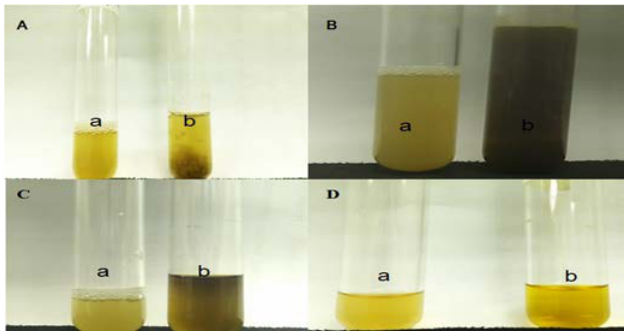
Figure 8. Phytochemical qualitative analyses of S. polyanthum leaf methanolic extract (ME): ( A ) Green-blue precipitate (b), indicating the presence of tannins (a: before; b: after ferric